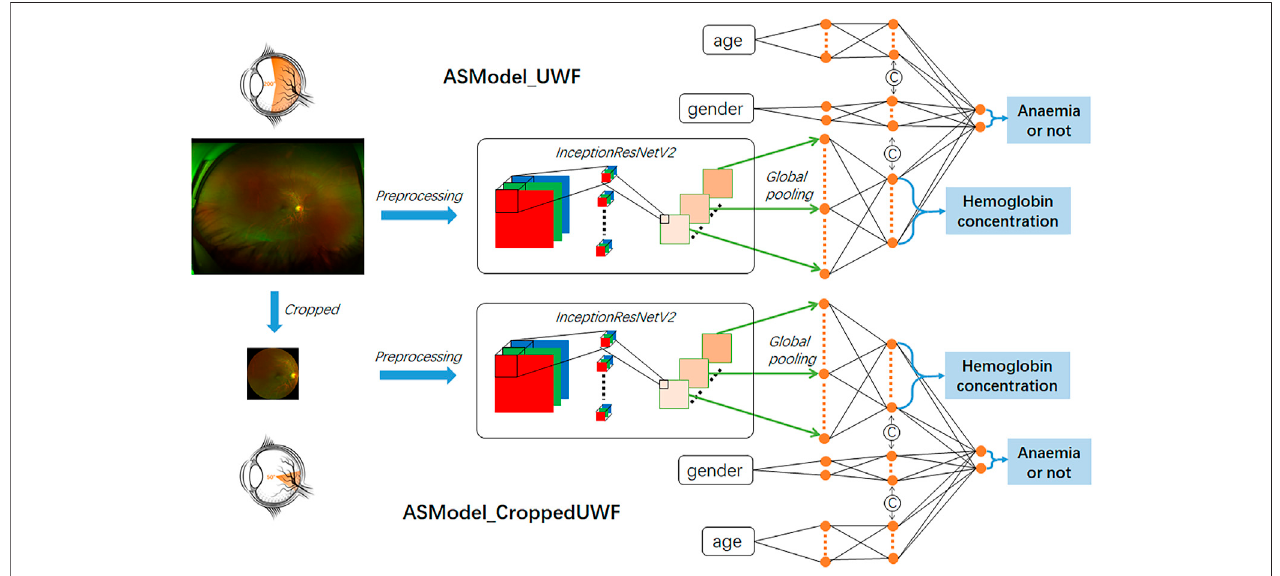
FIGURE 1 | Illustration of our constructed network architecture for hemoglobin concentration prediction and anemia screening based on UWF fundus images. ASModel_UWF is the model trained by original UWF fundus images, while ASModel_CroppedUWF is the model trained by the cropped UWF images.